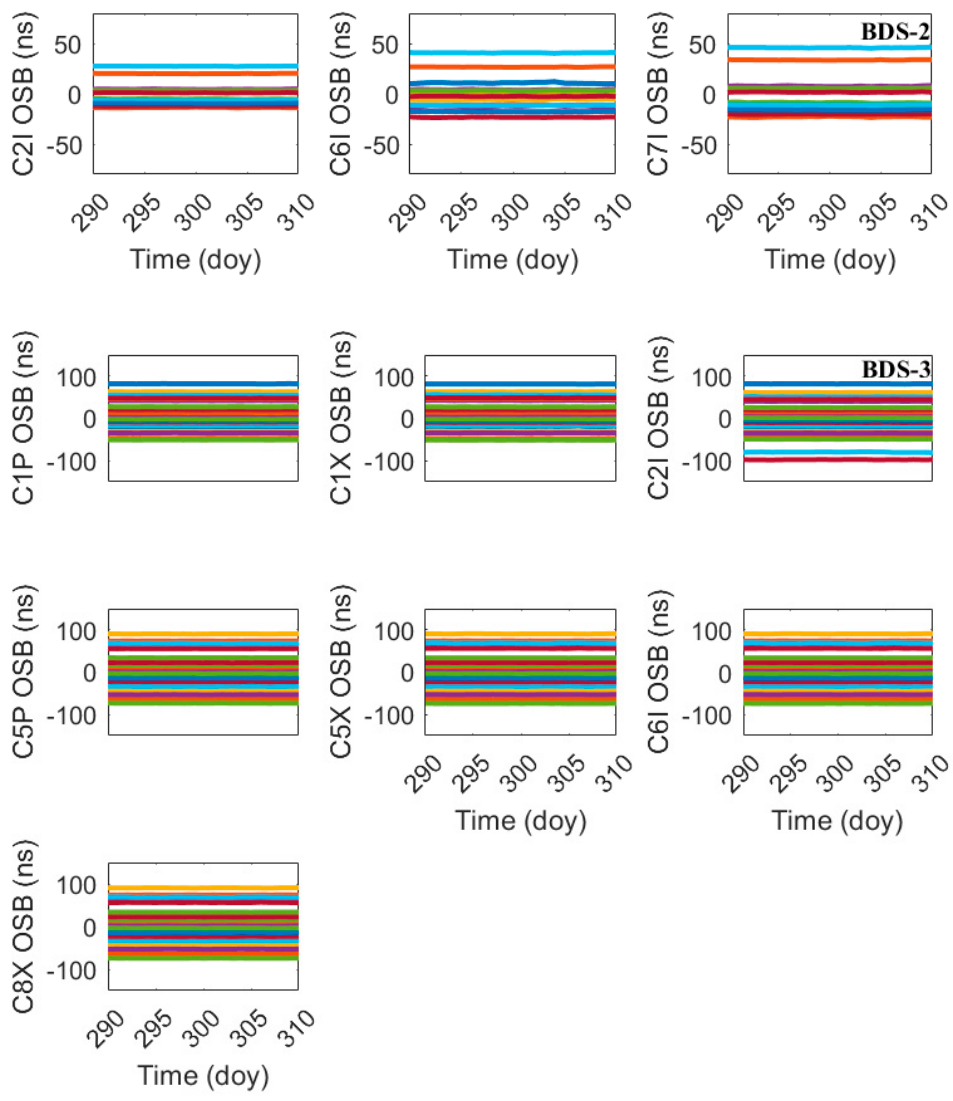
Figure 6. The multi-GNSS code OSB series from DOY 290, 2021 to DOY 310, 2021. A different color line represents a different satellite. Table 4. The STDs of multi-GNSS code OSBs during the selected period. (ns).